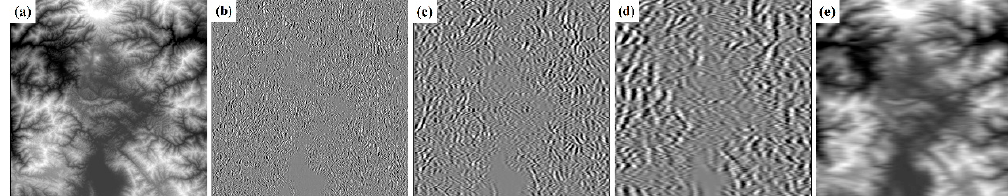
Figure 6. Schematic of N-AMD decomposition, including: ( a ) the original AW3D30, ( b ) the first-level component, ( c ) the second-level component, ( d ) the third-level component, and ( e ) the Residue .